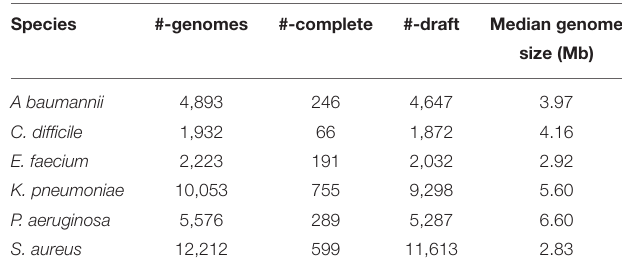
TABLE 1 | Table summary of the number of ESKAPE+C genomes